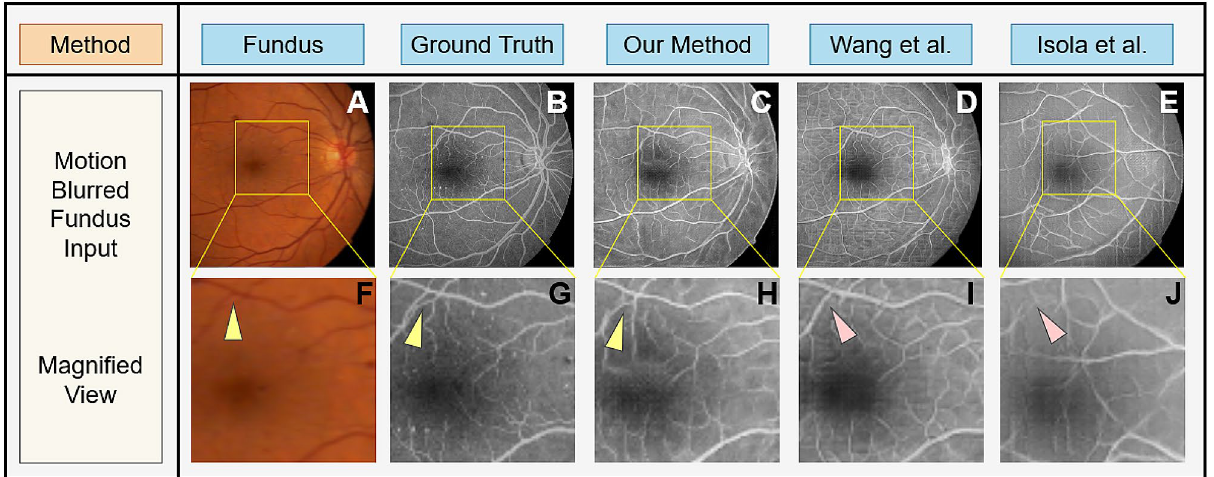
Figure 7. Paired fundus photographs ( A ) acquired under motion blur and ground truth FA images ( B ). FA images generated by our proposed method ( C) and those generated by traditional GANs proposed by Wang et al. ( D ) 50 and Isola et al. ( E ) 27 . Subfigures ( F–J ) show magnification of the yellow boxed areas from ( A–E ). Microvascular structures are not quite visible in the fundus photographs ( A,F ), but are visible in the original FA images ( B,G ) pointed to by the yellow triangles. Our deep learning GAN is capable of producing these microvascular structures pointed to by the yellow triangle, as well as macro vasular structures ( C,H ). The GAN proposed by Wang et al. 50 misses these microvascular structures ( D,I ) while GAN proposed by Isola et al. 27 is not able to produce any reliable vascular structure ( E,J )—red